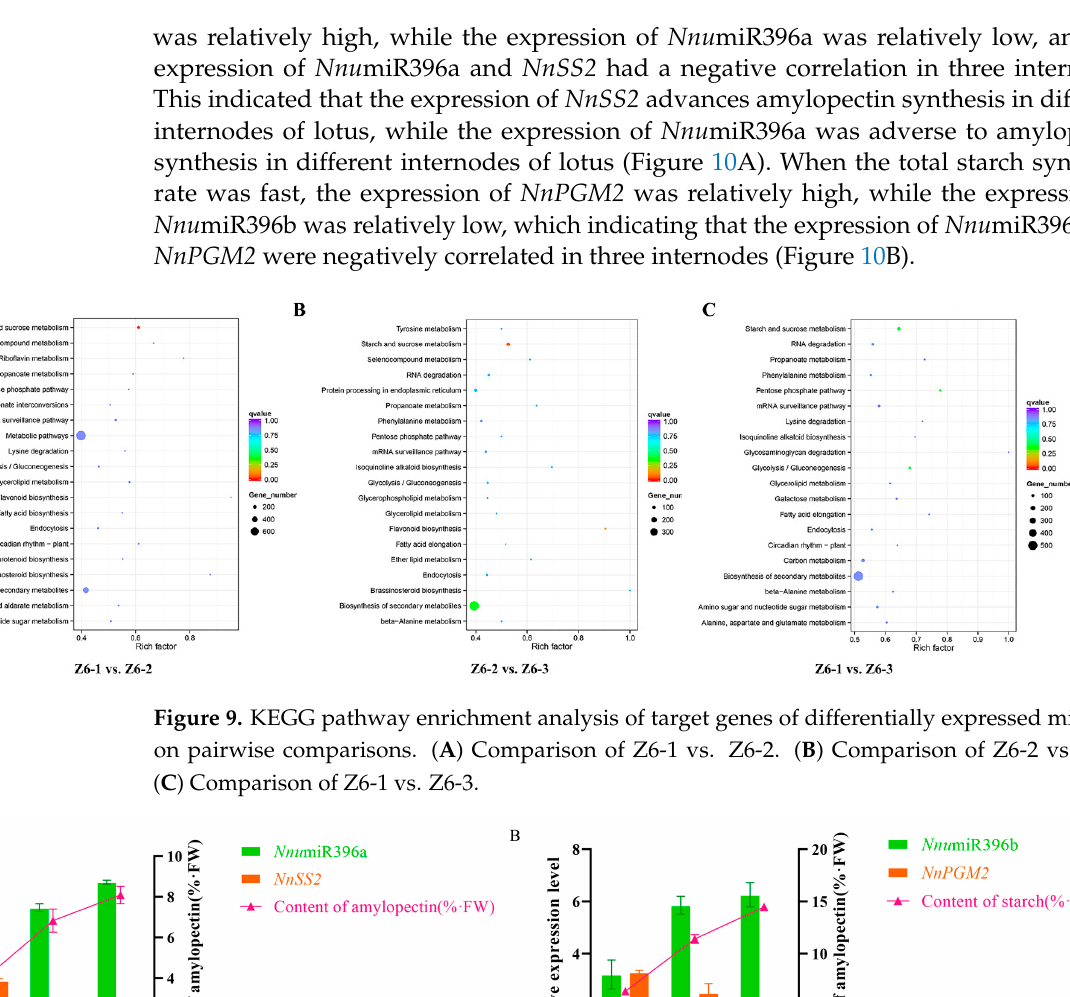
Figure 8. GO enrichment analysis of target genes of differentially expressed miRNAs on pairwise comparisons. ( A ) Comparison of Z6-1 vs. Z6-2. ( B ) Comparison of Z6-2 vs. Z6-3. ( C ) Comparison of Z6-1 vs. Z6-3.